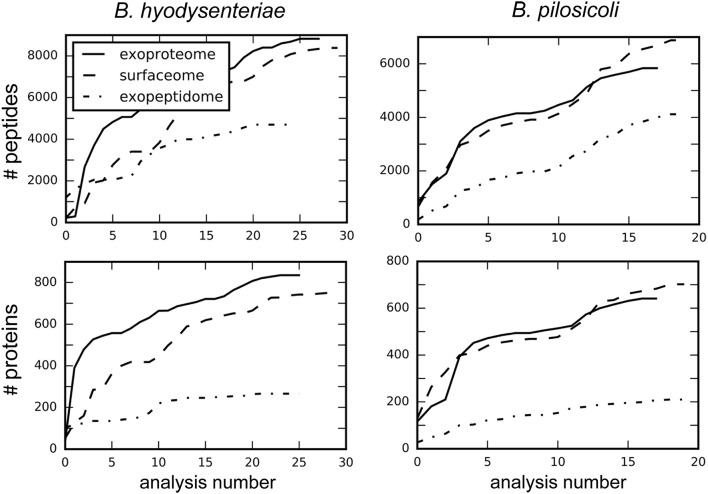
Increase in the total number of identified peptides and proteins with the number of combined analyses. Values were obtained by searching each independent file with Proteome Discoverer 1.4.